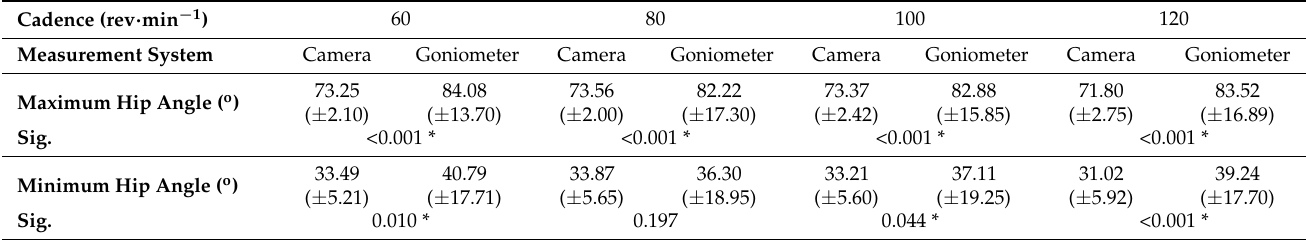
Table 2. Comparison of mean maximum and mean minimum hip angle recorded across 10 pedal